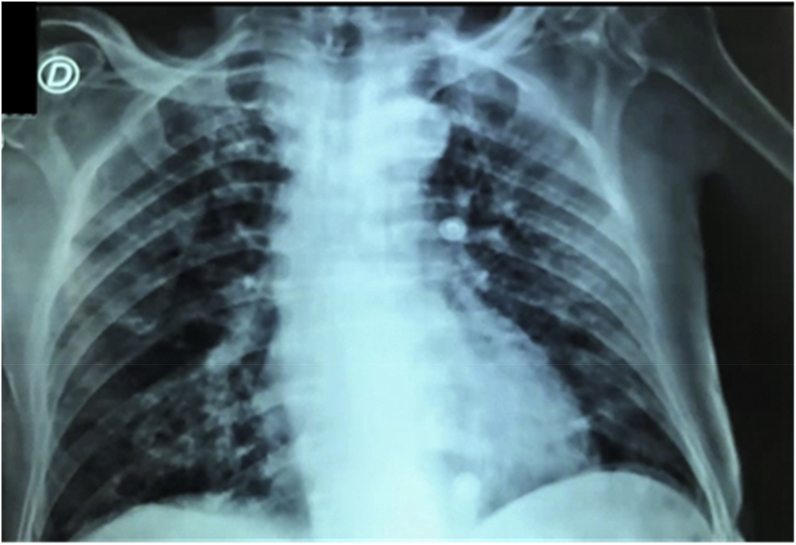
Chest X-ray evidenced bilateral heterogeneous infiltrates on day 26 of hospitalization: picture from the COVID-19 associated pulmonary aspergillosis (CAPA) described on this report.